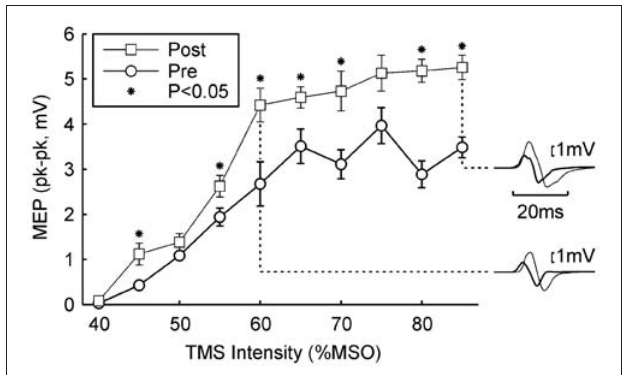
FIGURE 2 | Example result in one subject. The peak-to-peak height of the MEP is plotted against the TMS intensity (mean ± SEM). Circles show responses recorded in the morning, before wearable device use; squares show responses recorded in the afternoon, after 5.4 h of wearable device action. Asterisks denote responses which were significantly different between the two measurements ( P < 0.05). Insets on the right illustrate averaged MEPs for intensities of 60% and 85% maximum stimulator output (MSO); thick traces are MEPs before wearable device use, thin lines after. Protocol Rest .